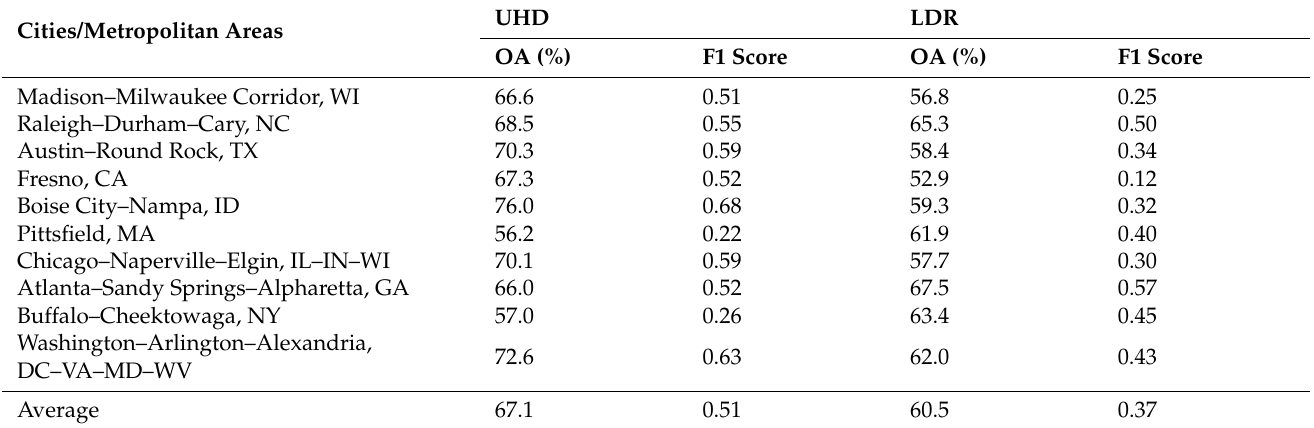
Table 2. Accuracy assessment of projected UHD growth from 2001 to 2016 compared with actual